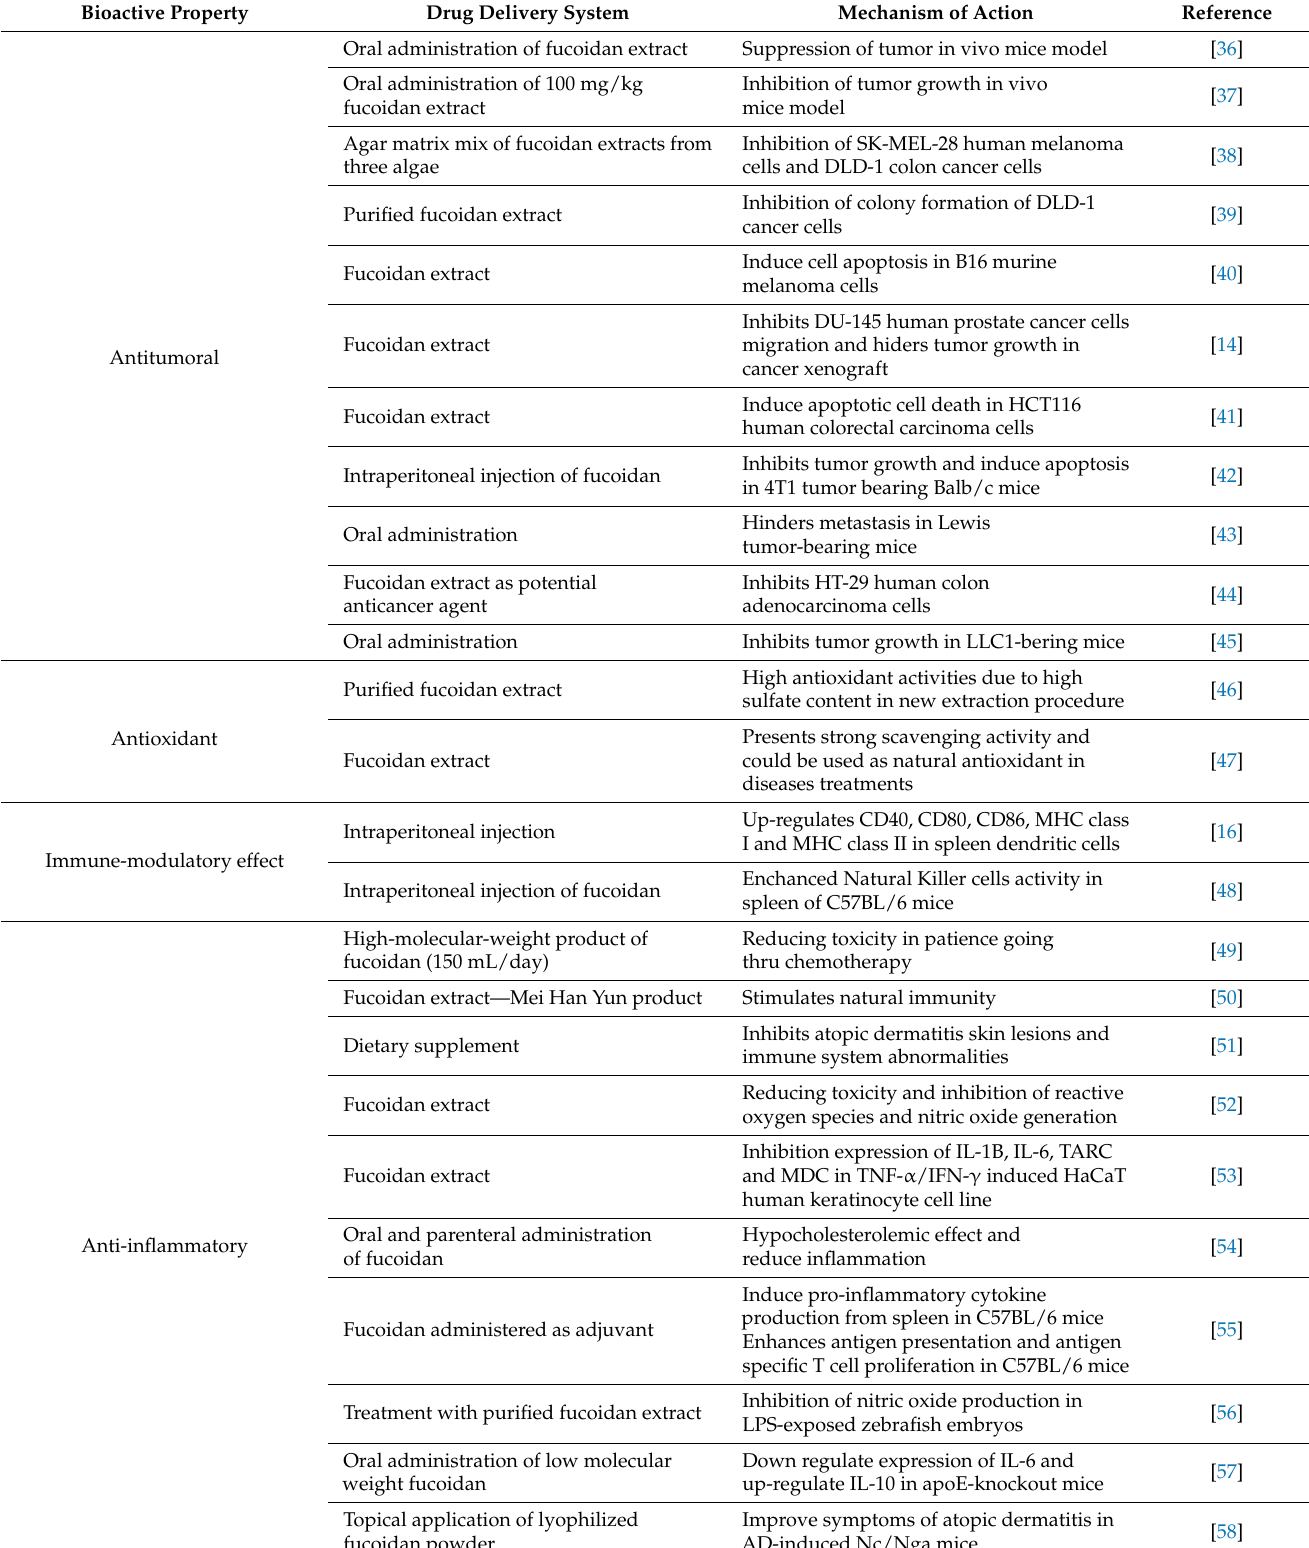
Table 2. Summary of fucoidan and the delivery systems used for various bioactive properties